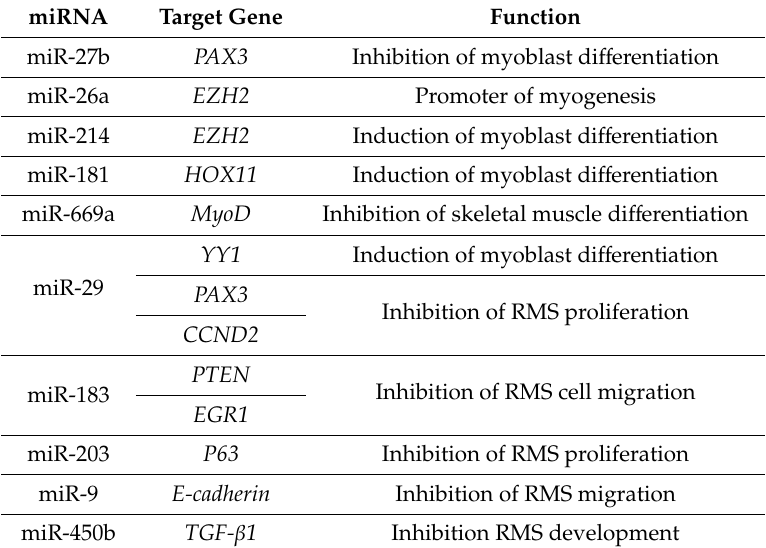
Table 3. Non-myomiRNAs and their function in